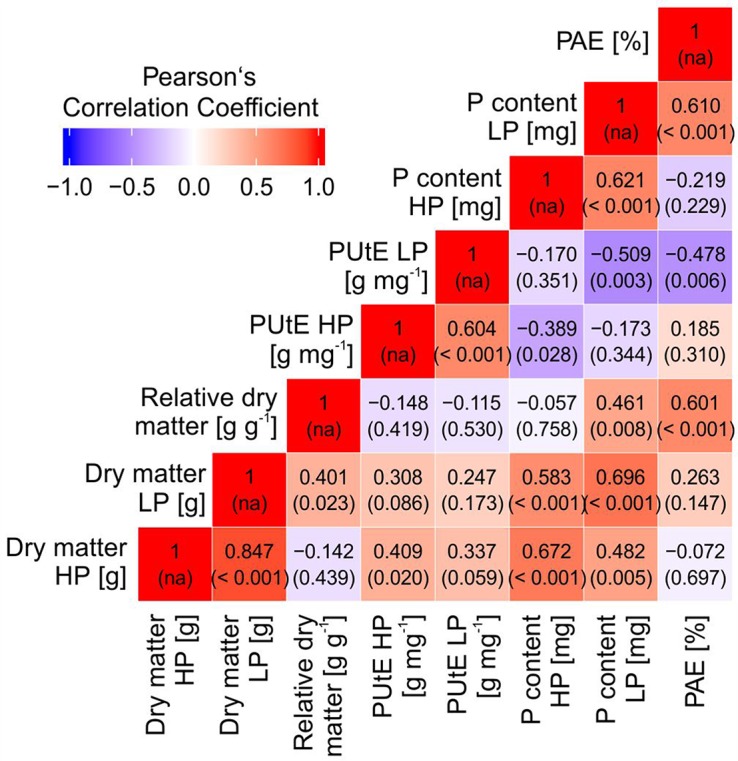
Pearson’s correlation coefficients (and p values of correlation) between dry matter, relative dry matter, phosphorus utilization efficiency (PUtE), plant phosphorus content at high (HP) and low P (LP), and phosphorus acquisition efficiency (PAE).